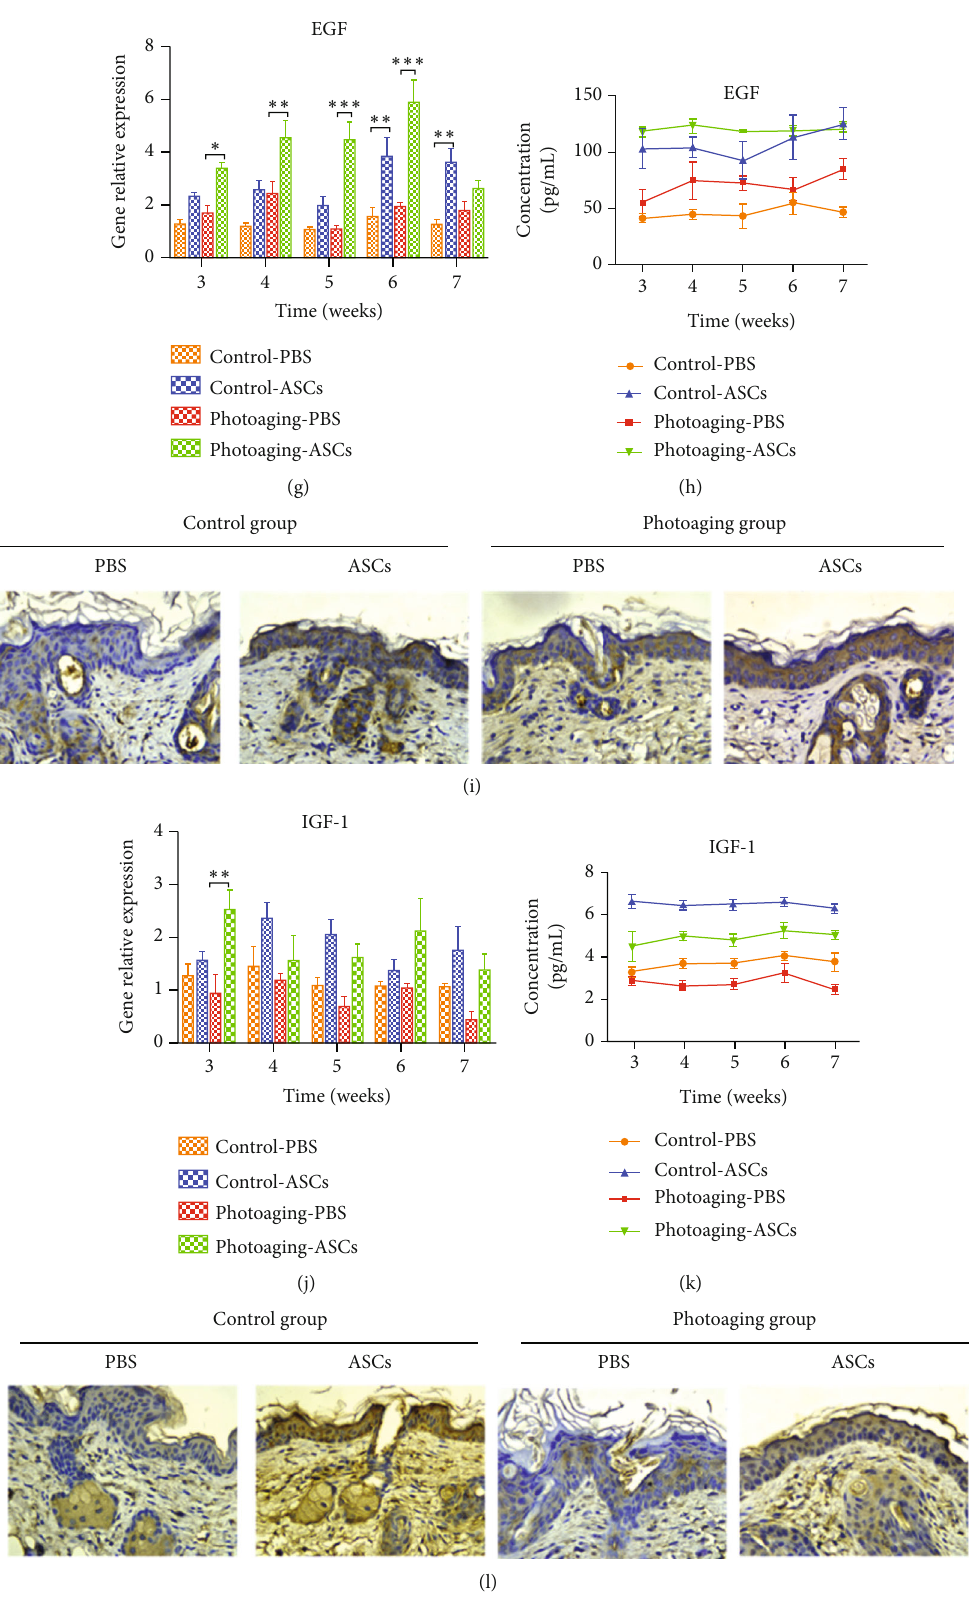
Figure 6: The levels of MMP-1, TGF- β 1, EGF, and IGF-1 in mouse skin. (a, d, g, j) RT-PCR results showing gene expression in mouse skin. (b, e, h, k) The level of cytokines in skin tissue homogenate. (c, f, i, l) Immunohistochemical labeling of cytokines at 7